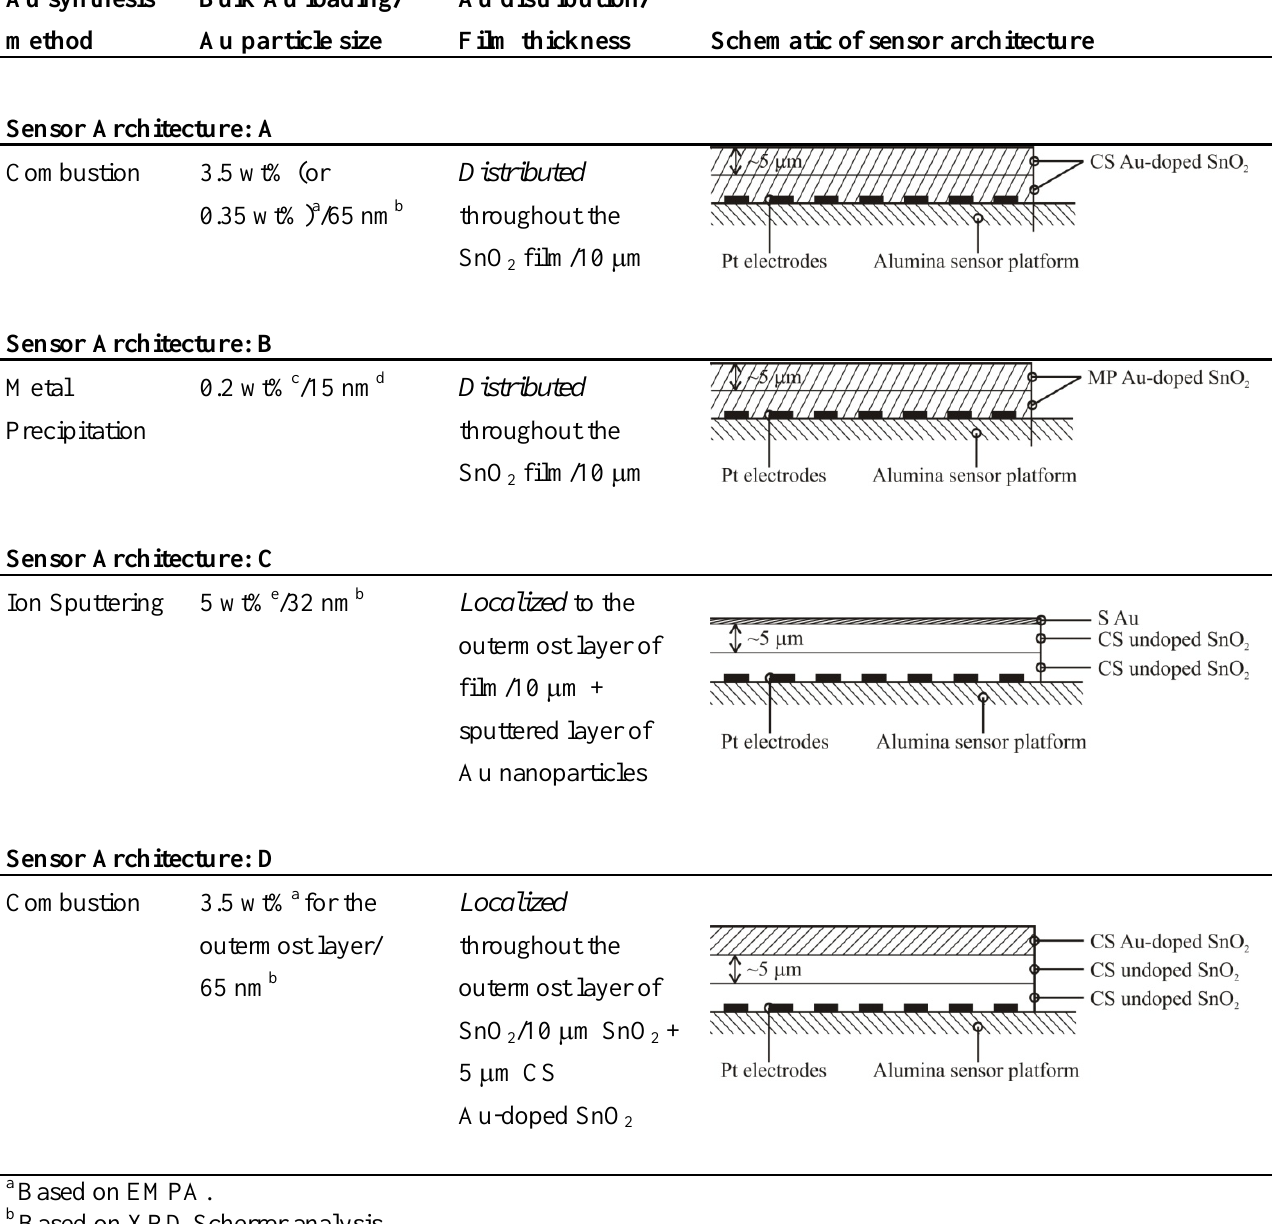
Table 1. Summary of Au/SnO generated by combustion synthesis with an average SnO XRD analysis, while Au additive synthesis and properties are indicated respective to the